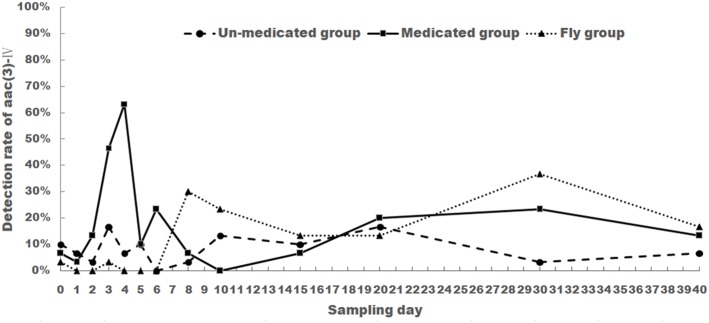
The changes of aac(3)-IV detection rate of E. coli isolated from chicken feces (medicated and un-medicated groups) and houseflies. Apramycin was administrated from Days 1 to 5 in their drinking water (0.5 mg/l) for the medicated group.